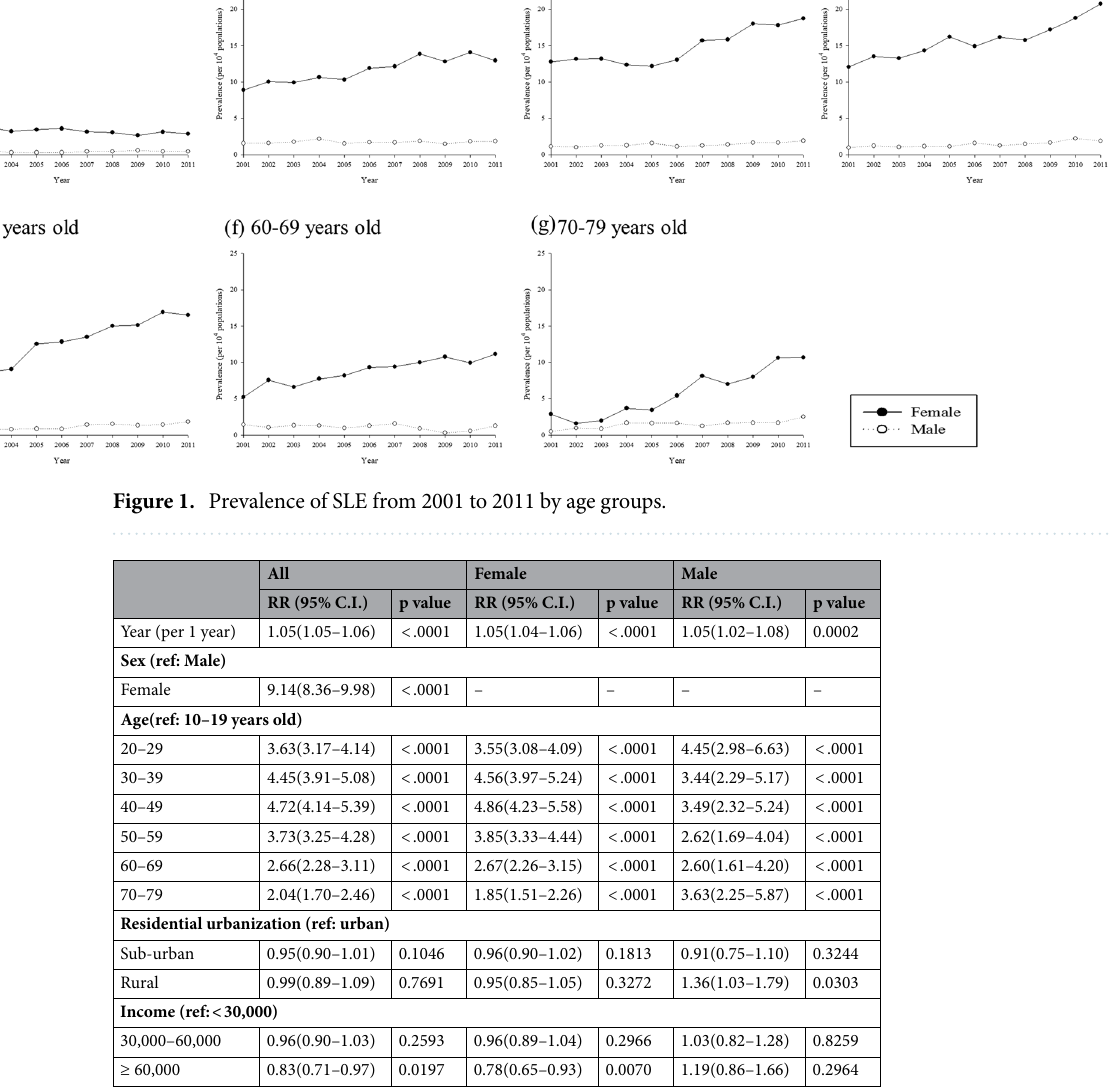
Table 2. Relative risk of prevalent cases of SLE in Taiwan from 2001 to 2011 by using multiple Poisson regression*. *Models were adjusted for calendar year, sex, age groups, urbanization and income levels.